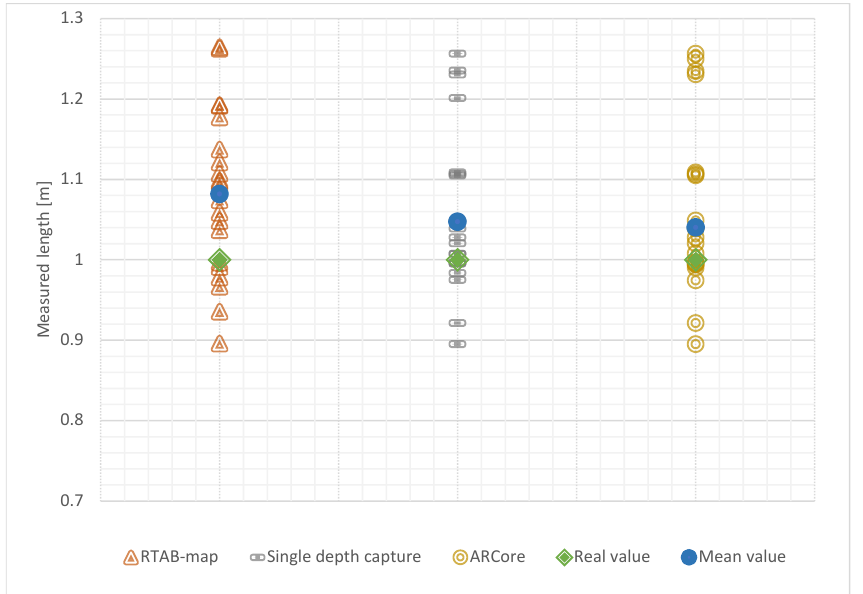
Figure 5. Plot of the measured